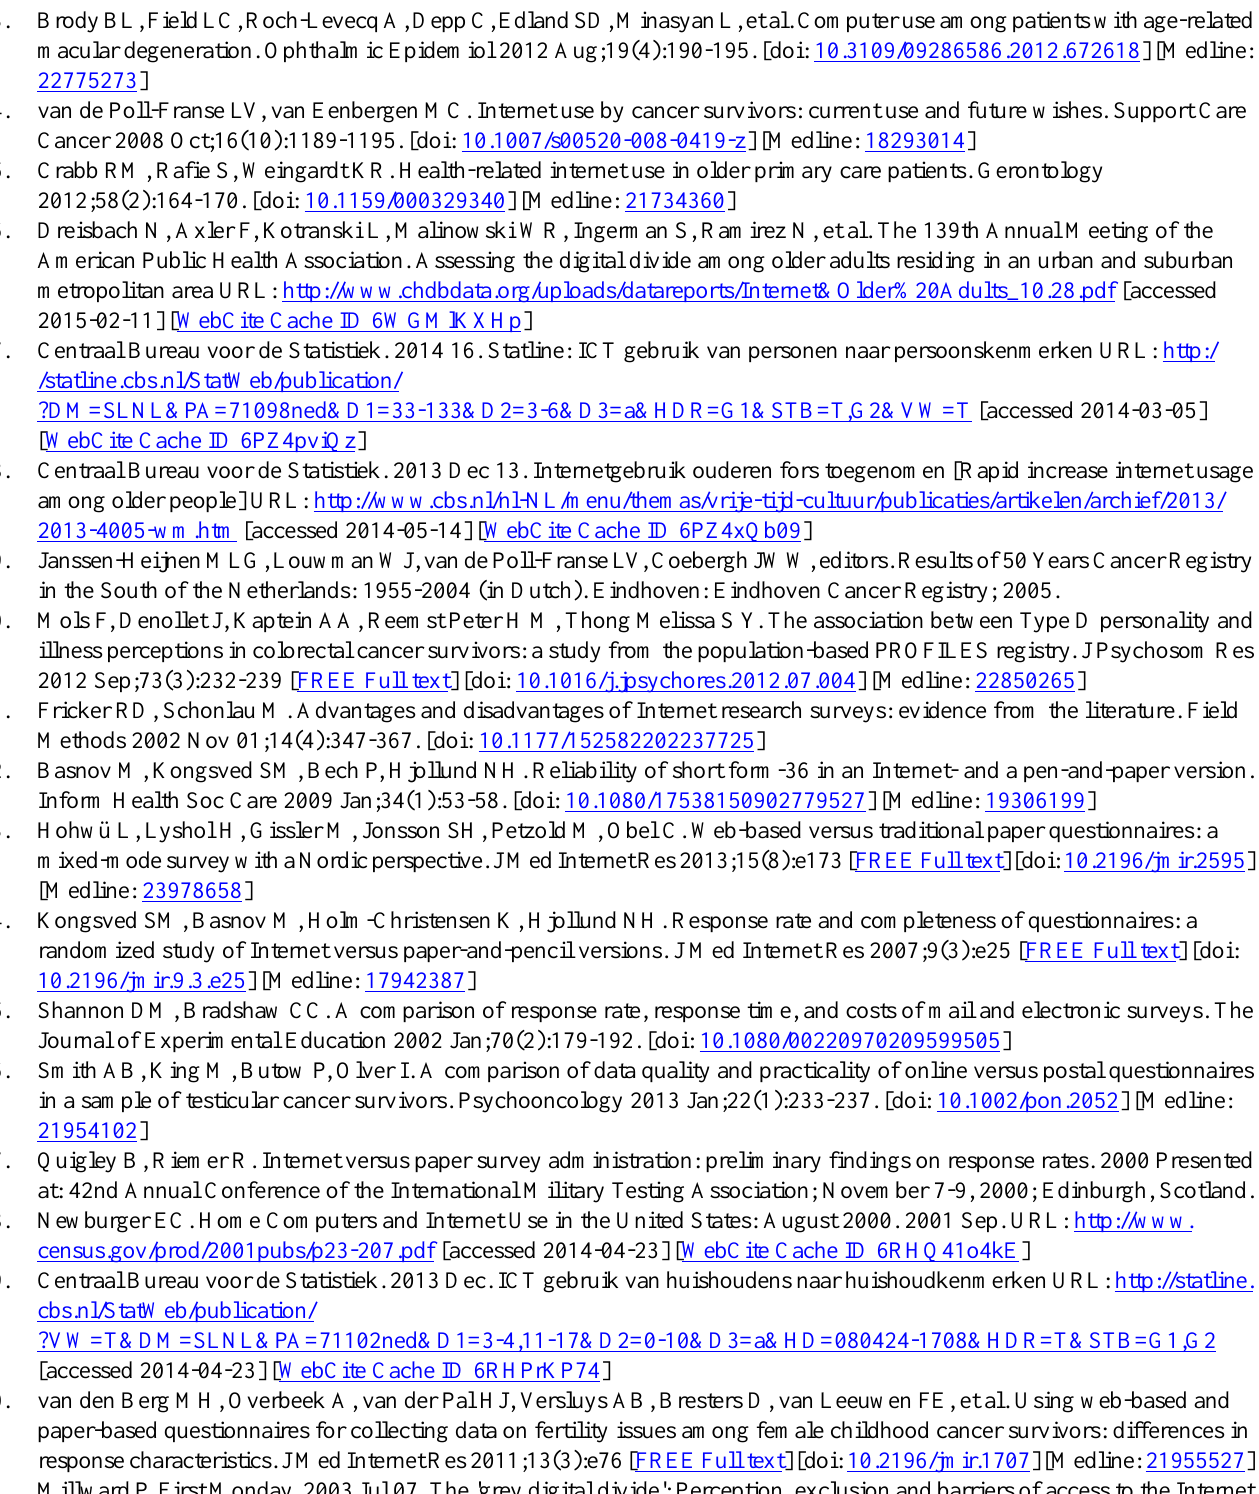
CRC: colorectal cancer ECR: Eindhoven Cancer